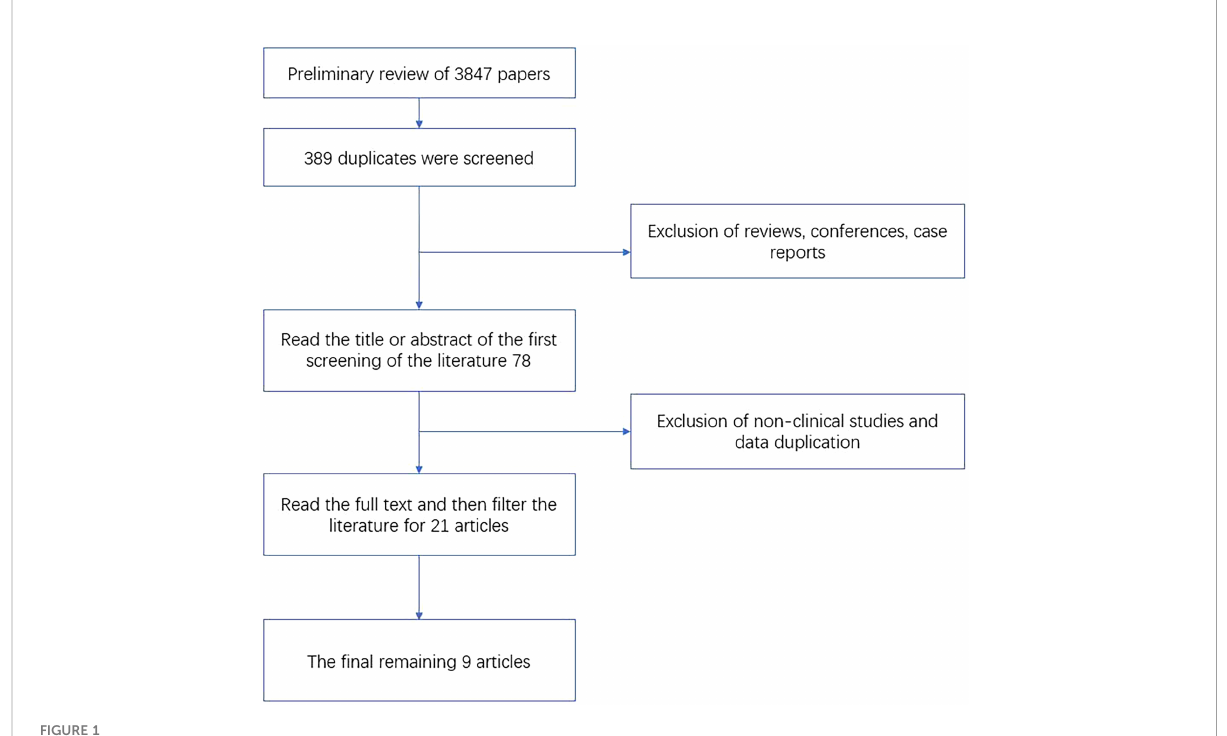
FIGURE 1 Flow chart of literature